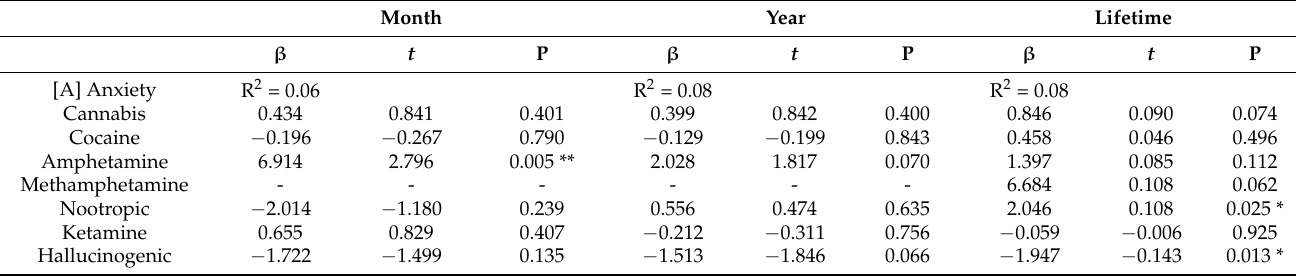
Table 4. Substance type as predictors of anxiety, depression, stress, and